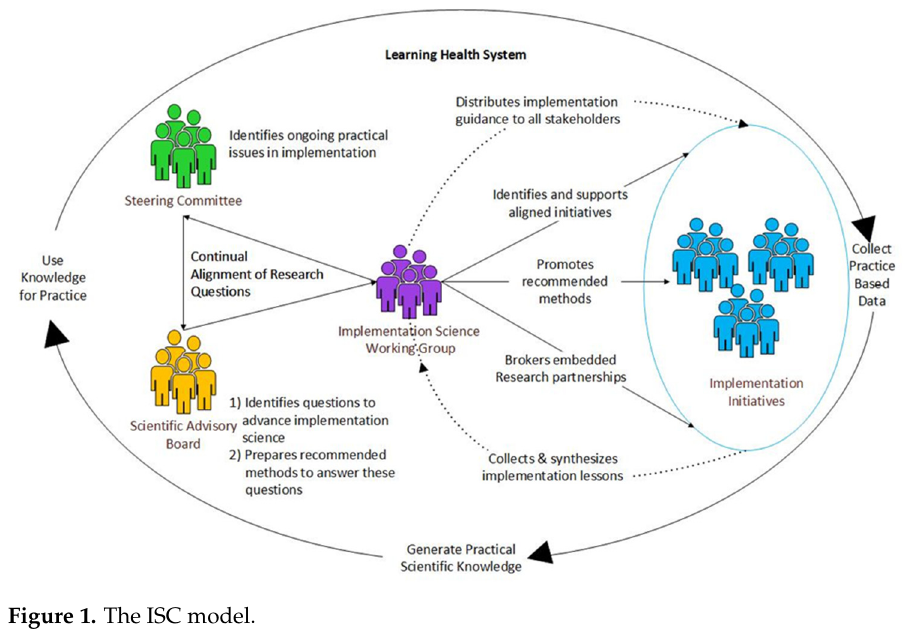
Figure 1. The ISC model.